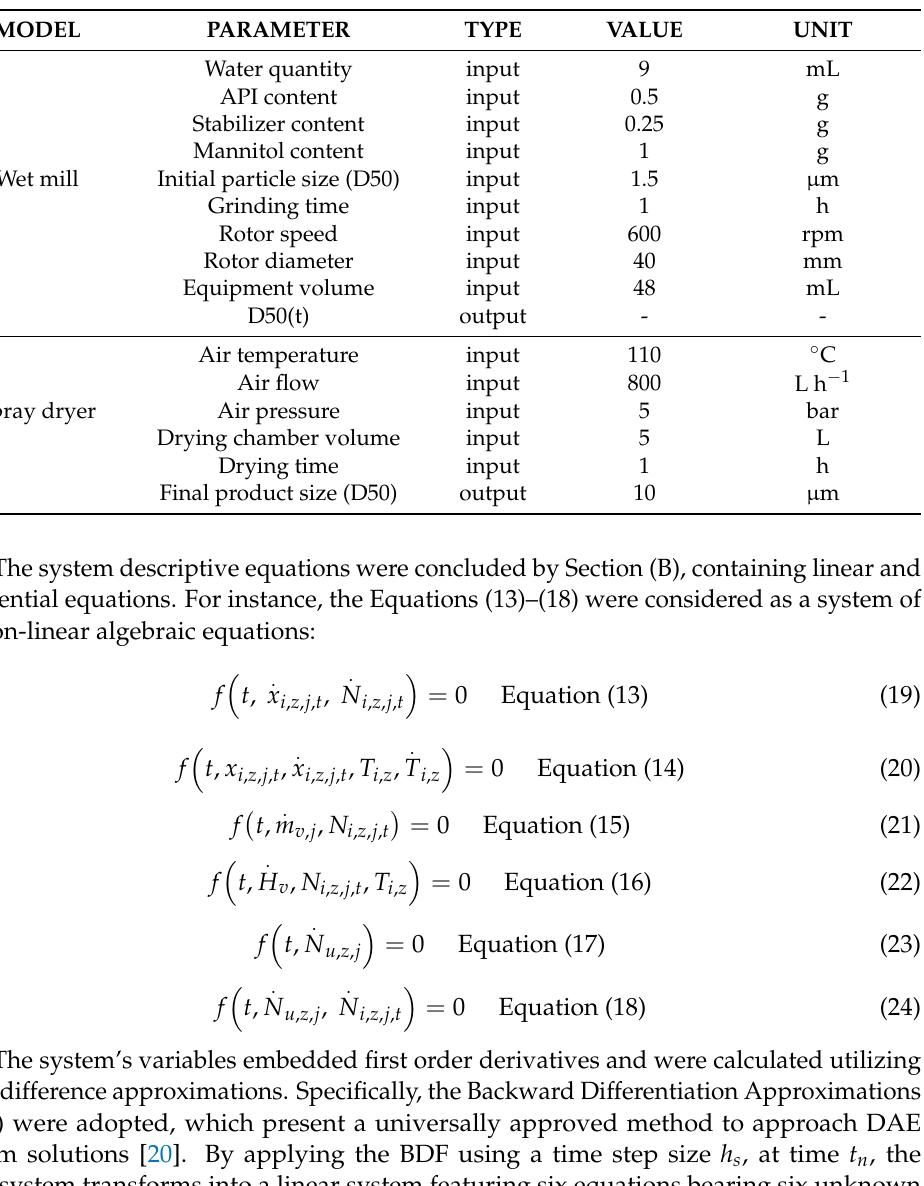
Table 3. Input and output parameters considered for the development of the digital